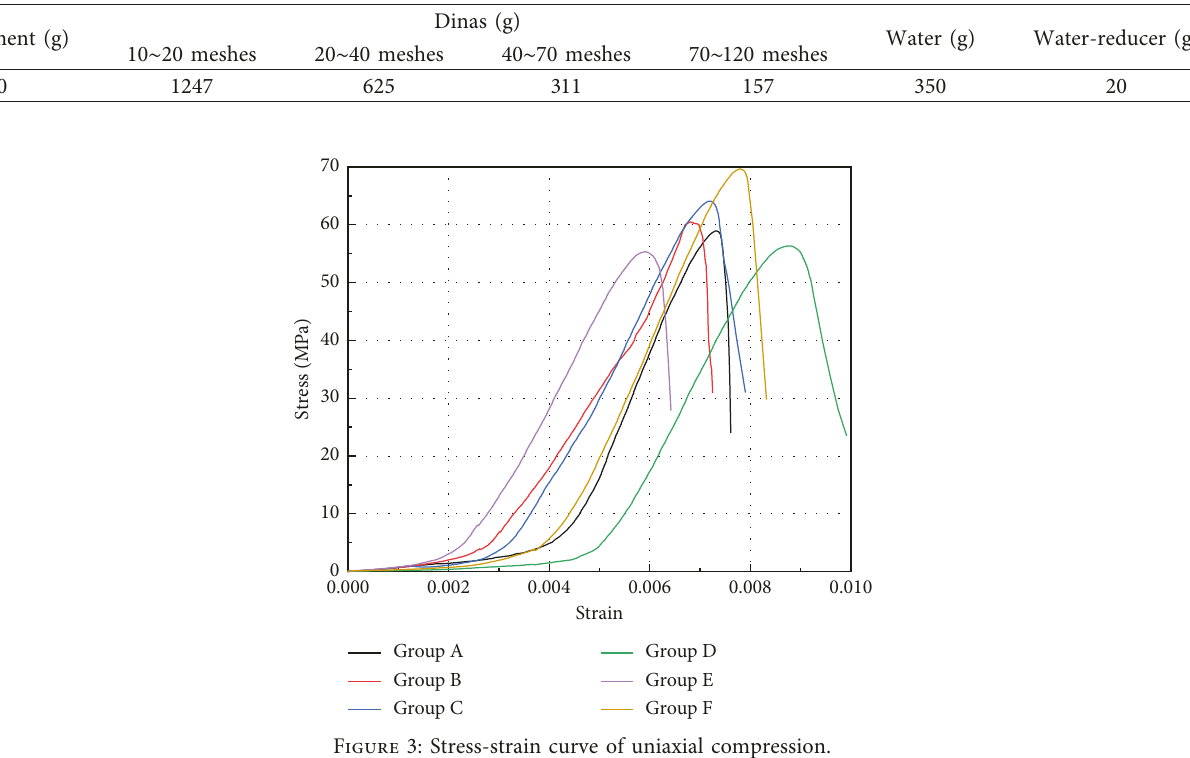
Figure 3: Stress-strain curve of uniaxial compression.